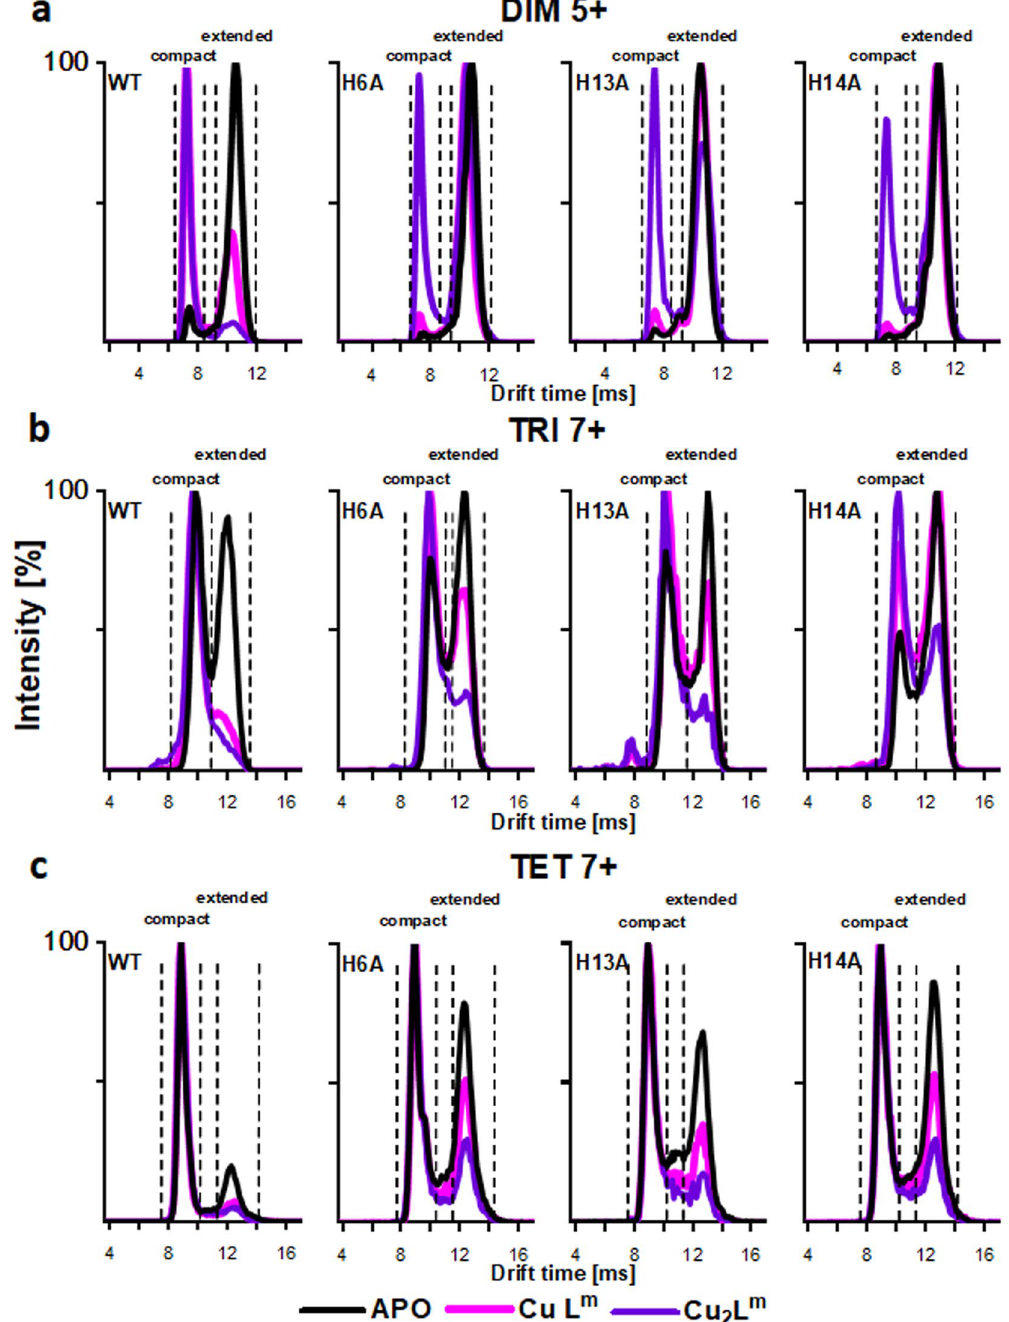
Figure 6. IM-MS drift time profiles of three selected regions corresponding to DIM 5 + ( a ), TRI 7 + ( b ) and TET 7 + ( c ) species, extracted from spectra of WT A β 1–40, H6A, H13A and H14A collected in the presence of metal ions Cu(II), Cu(II) bound in complexes at different ratios (Cu n L m ), where L indicates metal-liganding peptide molecule. Drift time profiles present complex of ligand-particular oligomeric charge state (L m ) with different amounts number n of metal ions (Cu n ), CuL m (pink), Cu 2 L m (purple) and compared to the control spectra collected in the absence of metals